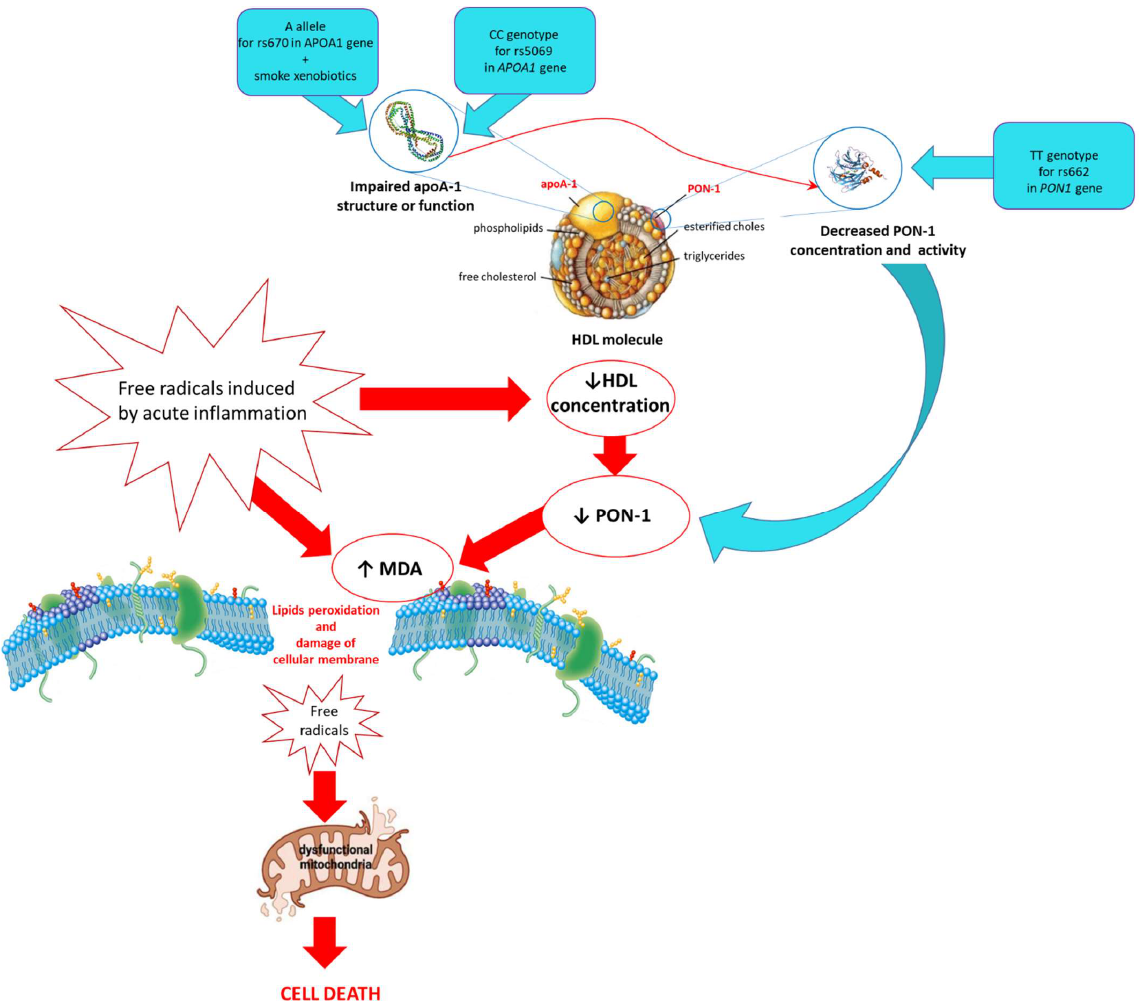
Figure 2. The involvement of environmental and genetic factors (SNPs: rs662, rs670 and rs5069) in the disorder of cellular pro/antioxidant balance in acute pancreatitis.